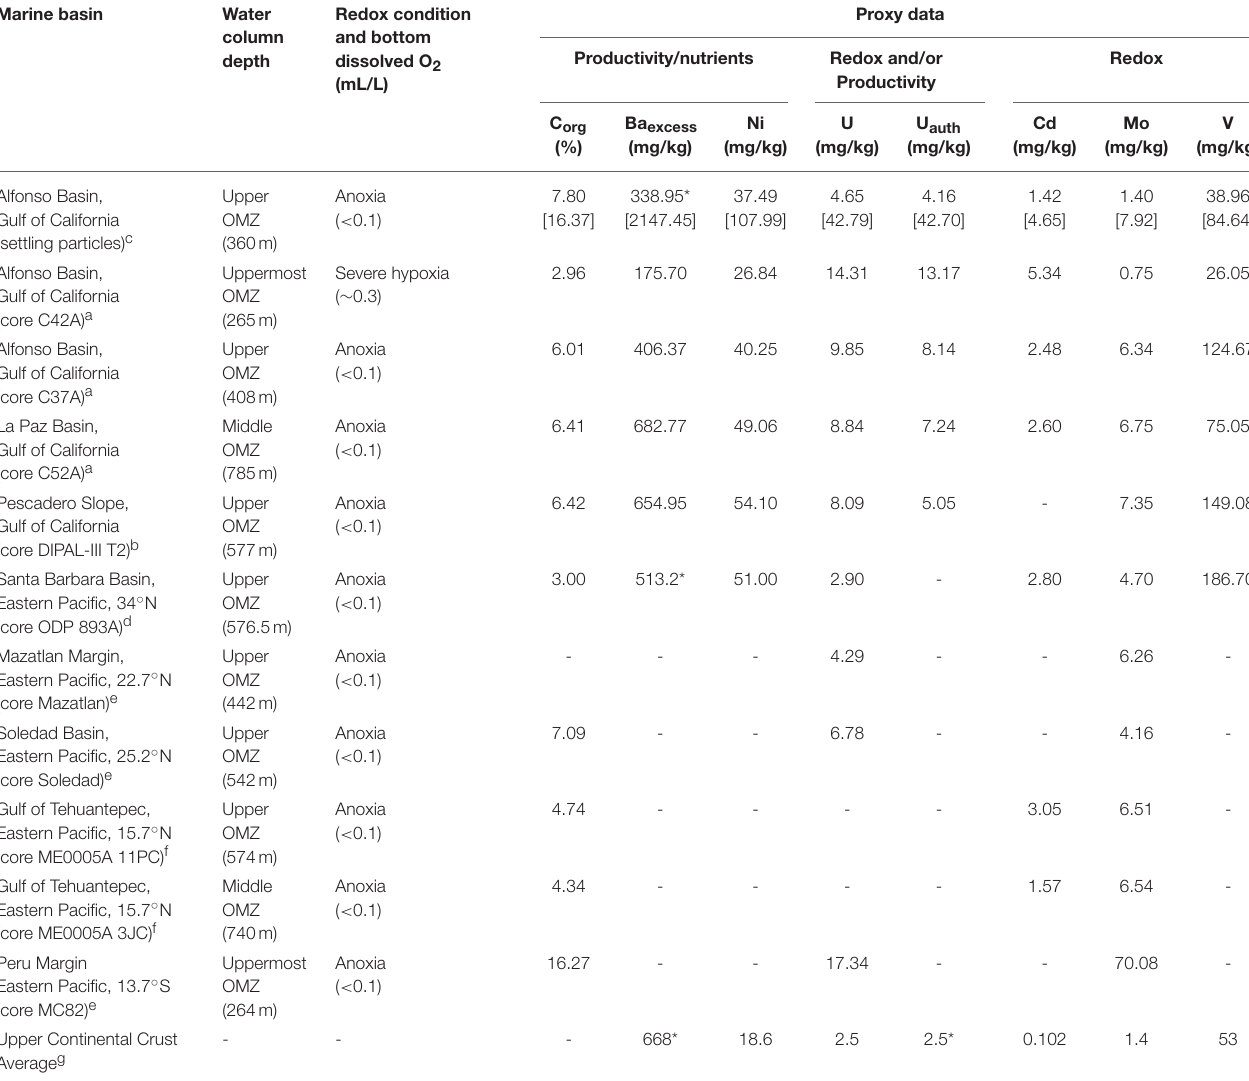
TABLE 5 | Comparison of productivity and/or redox proxy values for selected sedimentary material from different OMZ depths in the Eastern